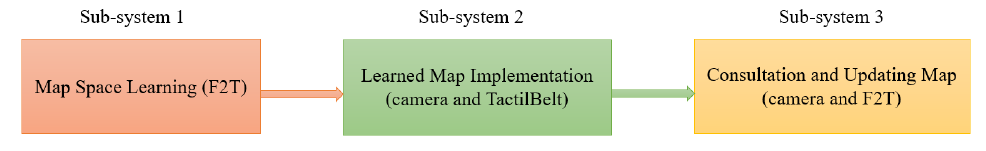
Figure 2. Model of VIP mobility assistance.